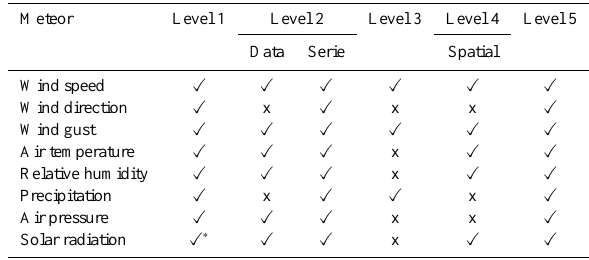
Table 2. Meteors and applied